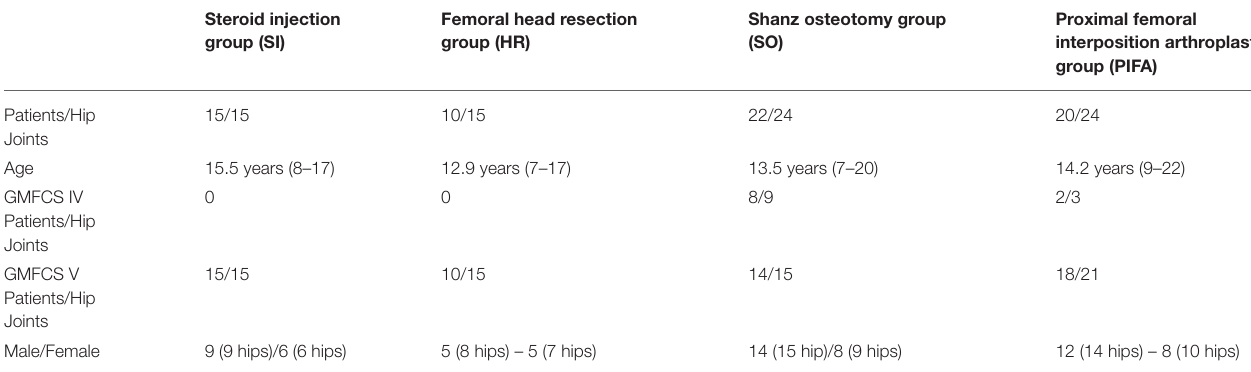
TABLE 1 | Description of the groups.